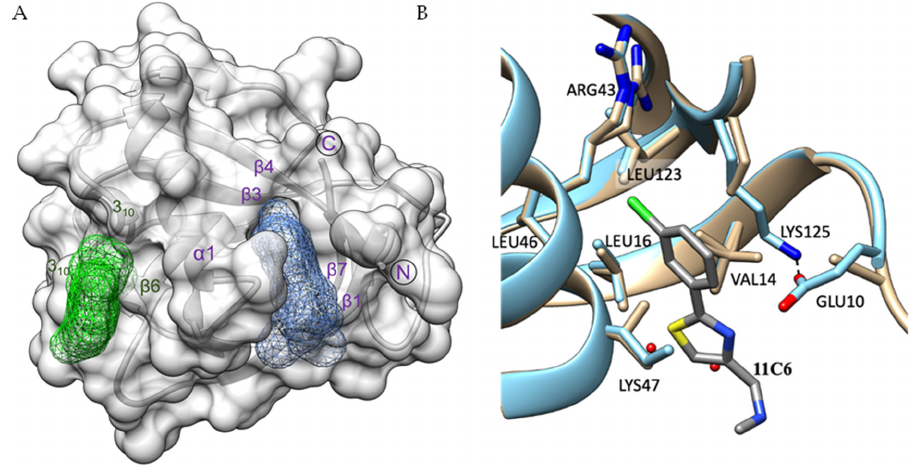
Figure 3. Binding sites I and II in SARS-CoV-2 nsp1 10-126 . ( A ) Surface representation of SARS-CoV-2 nsp1 10-126 shown in light grey indicating binding sites I (blue) and II (green). The secondary structures forming the two binding pockets are labelled in the corresponding colours with α 1 contributing to the formation of both pockets. ( B ) Overlay between native nsp1 (beige) and the SARS-CoV- 2 nsp1 10-126 -11C6 complex (blue) showing the structural changes induced by fragment binding. Table 2. List of SARS-CoV-2 nsp1 10-126 amino acids defining binding sites I and II. Binding Site